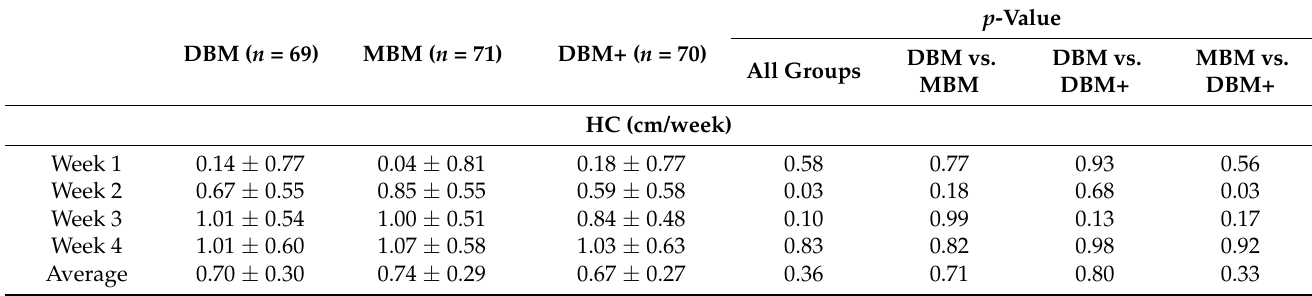
Table 6. Linear model of growth velocity comparisons between groups, adjusted for SGA, with MBM as reference.